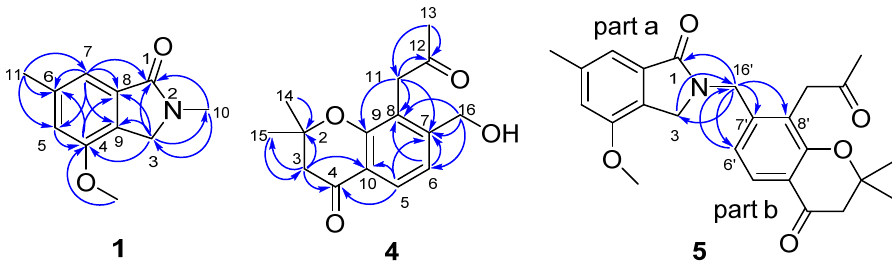
Figure 2. The key HMBC correlations of compounds 1 , 4 , and 5